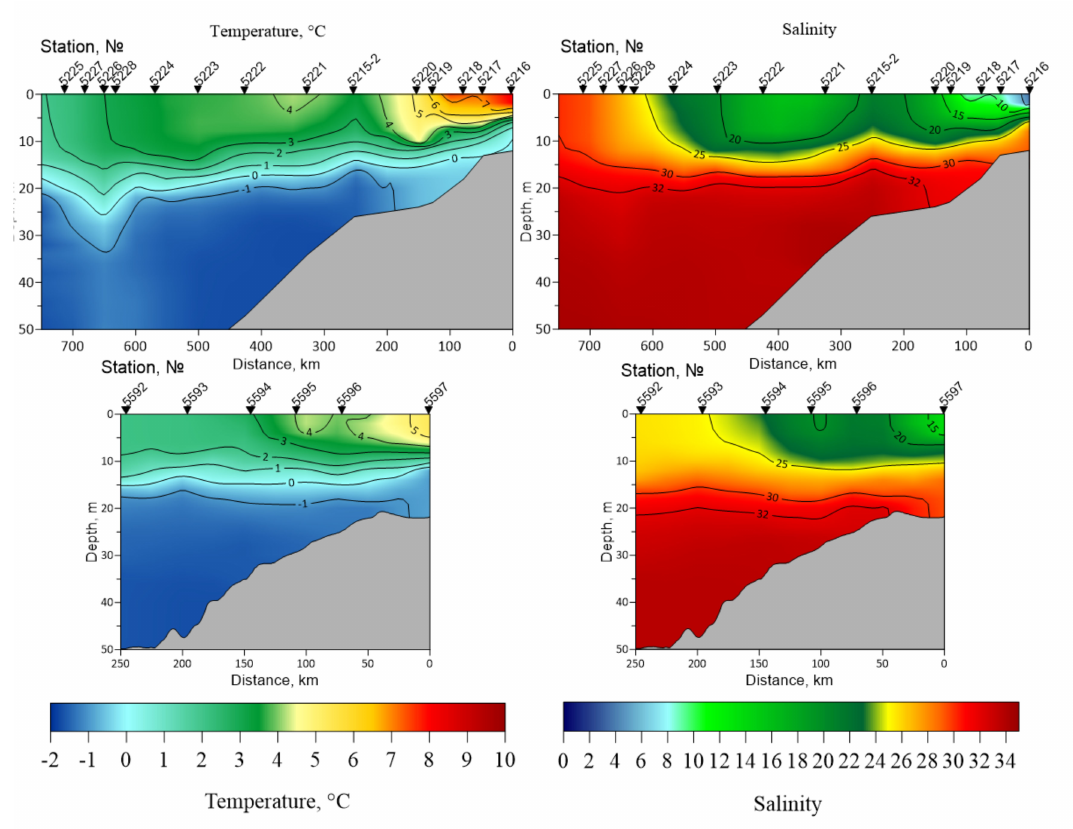
Figure 4. Temperature and salinity across the mixing zones of the Lena River in fall 2015 ( upper ) and 2017 ( lower ).